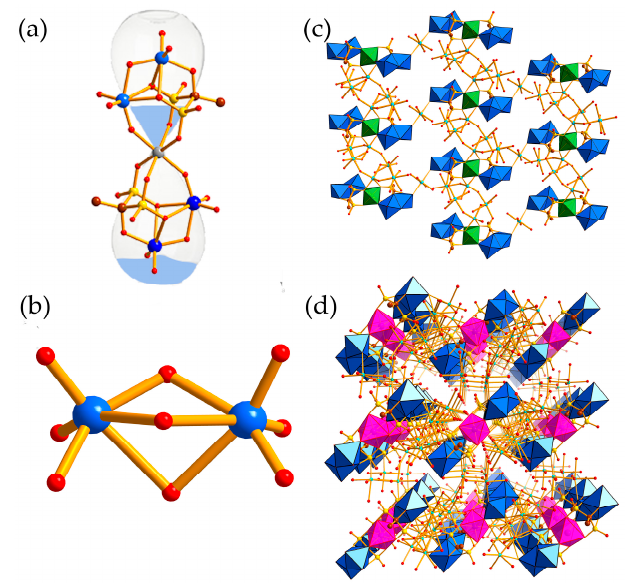
Figure 1. ( a ) polyhedral/ball-and-stick view of the monomer of compound 1 and 2 ; ( b ) Ball-and-stick view of {Mo VI2 O 5 } moieties; ( c ) the two-dimensional (2D) planar structure of compound 1 ; ( d ) the three-dimensional (3D) structure of compound 2 ; (MoO 6 /Mo: blue, tetrahedron of P/P: yellow, Co: amaranth, Ni: green, C: brown, O: red, Na: cyan-blue, Ni/Co: gray.) Table 1. Crystal data and structure refinements for the compounds 1 and 2 .